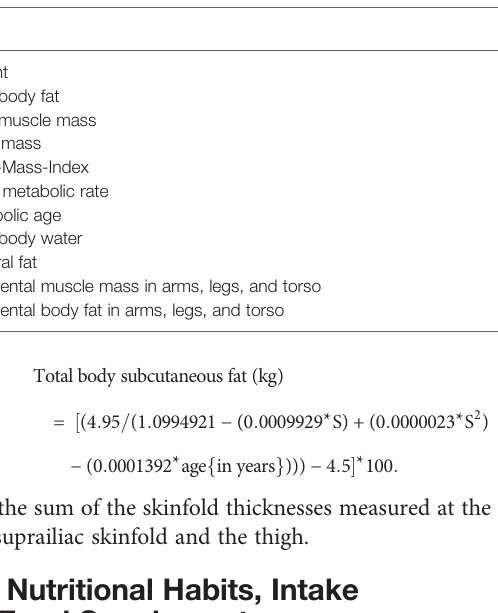
TABLE 4 | Measurements by scale and bioimpedance